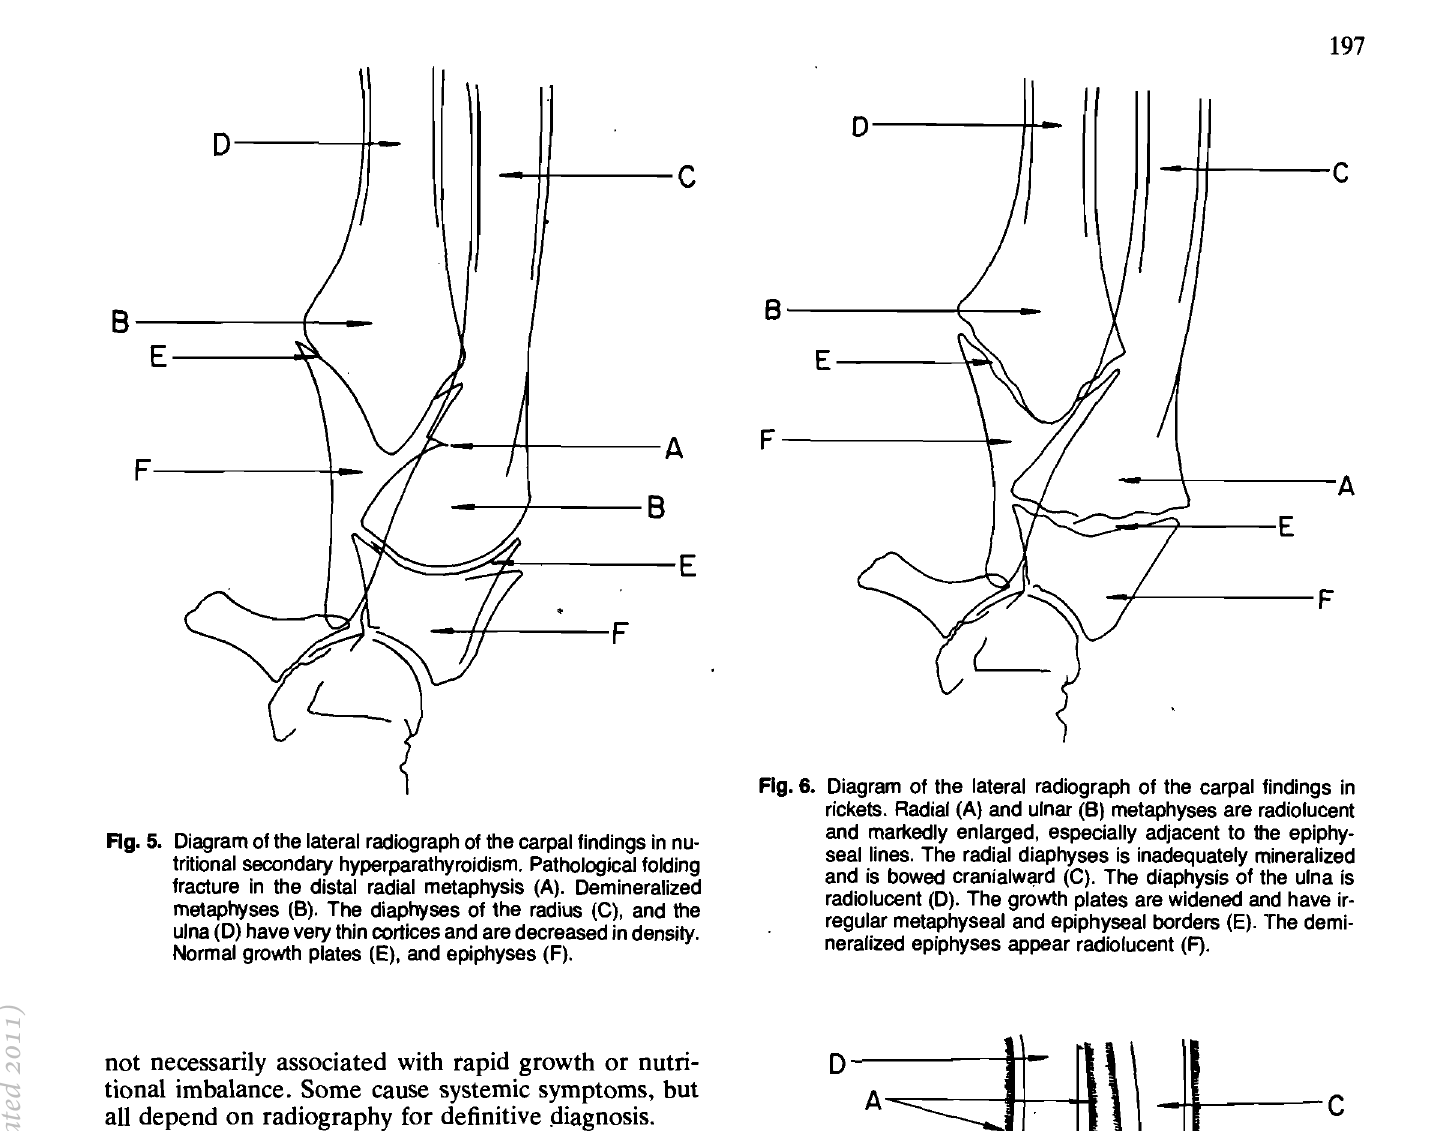
Fig. 5. Diagram of the lateral radiograph of the carpal findings in nu· tritional secondary hyperparathyroidism. Pathological folding fracture in the distal radial metaphysis (A). Demineralized metaphyses (8). The diaphyses of the radius (C), and the ulna (D) have very thin cortices and are decreased in density. Normal growth plates (E), and epiphyses (F).